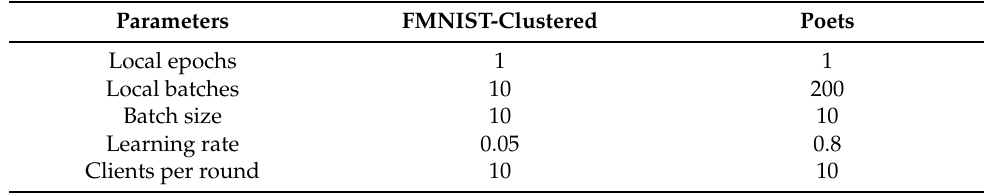
Table 4. Training Hyperparameters Setting of the Experiment. Parameters FMNIST-Clustered Poets Local epochs Local batches Learning rate Clients per